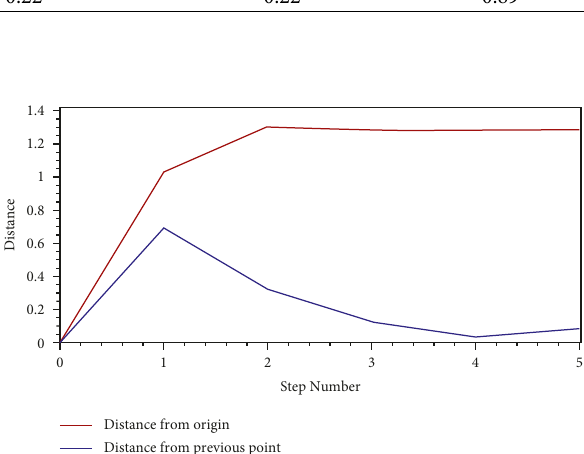
Figure 7: FORM analysis convergence diagram for type I frame in RT program.